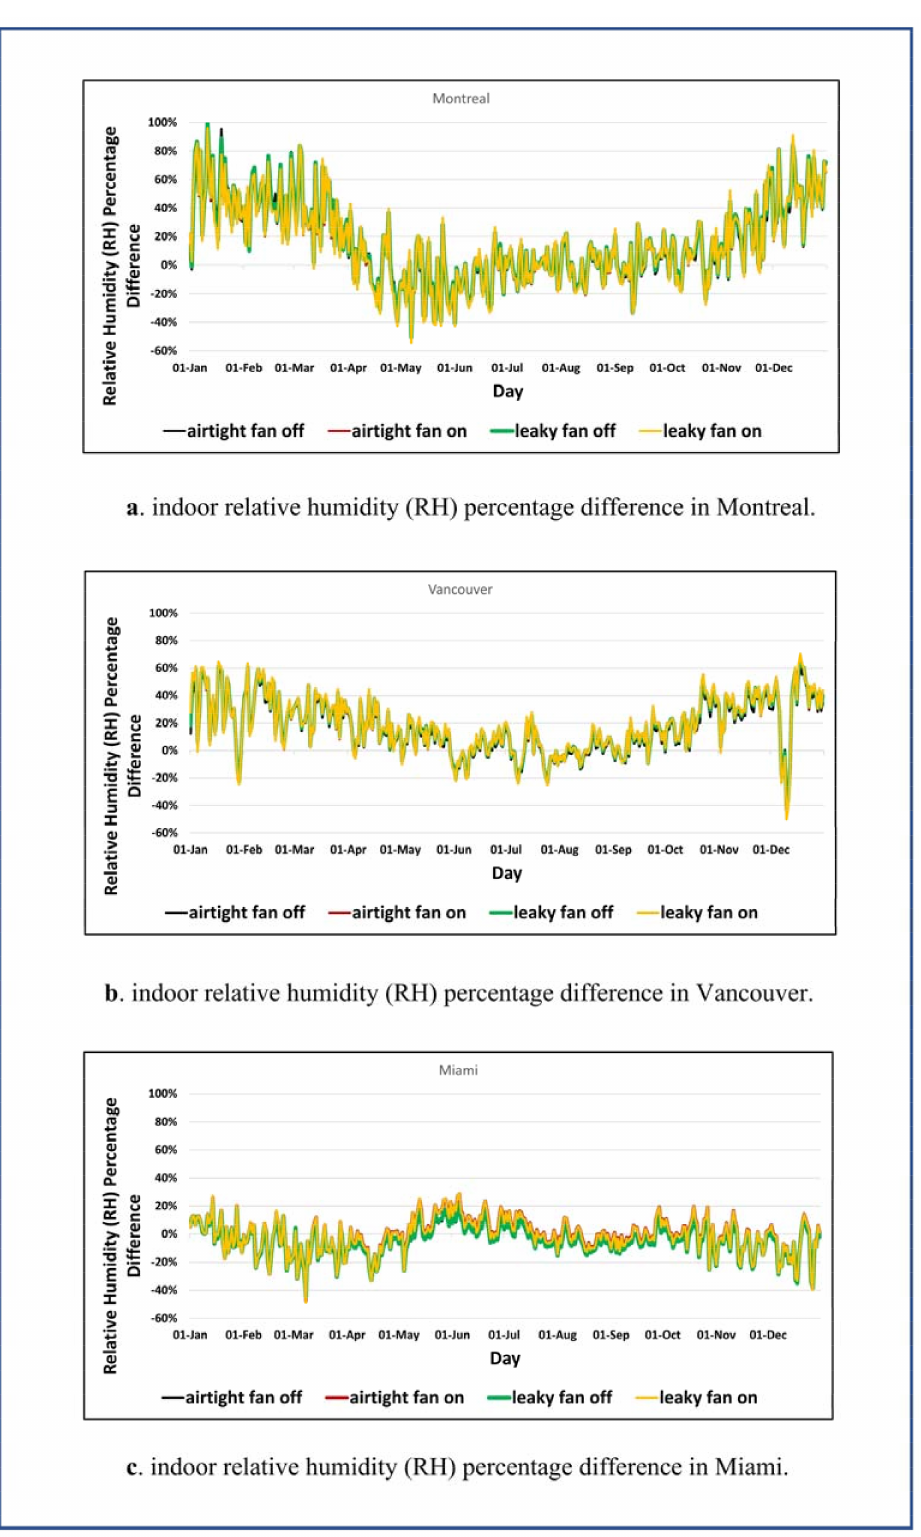
Figure 9. Comparison of the simulated integrated model results of hourly relative humidity (RH) with acceptable level of ASHRAE Standard 160 for ( a ) Montreal, ( b ) Vancouver, and ( c )